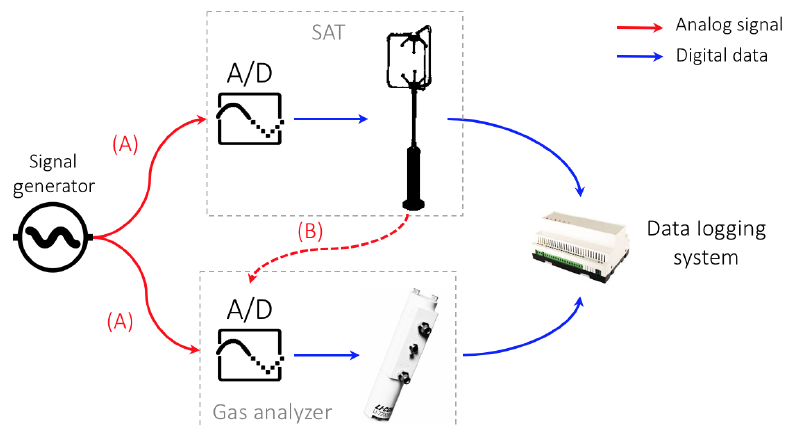
Figure 8. Schematic of possible setups to evaluate the ability of a data logging system to synchronize EC data. In setup A the same (known) analog signal (solid red lines) is sent to the analog inputs of the EC instruments where it is digitized. In setup B analog wind data (dashed red line) is sent to the gas analyzer, where it is digitized. In both setups, the two digital data streams are then collected by the data logging system. The clocks involved and how timestamps are attached to data depend on the specifics of the system under consideration.